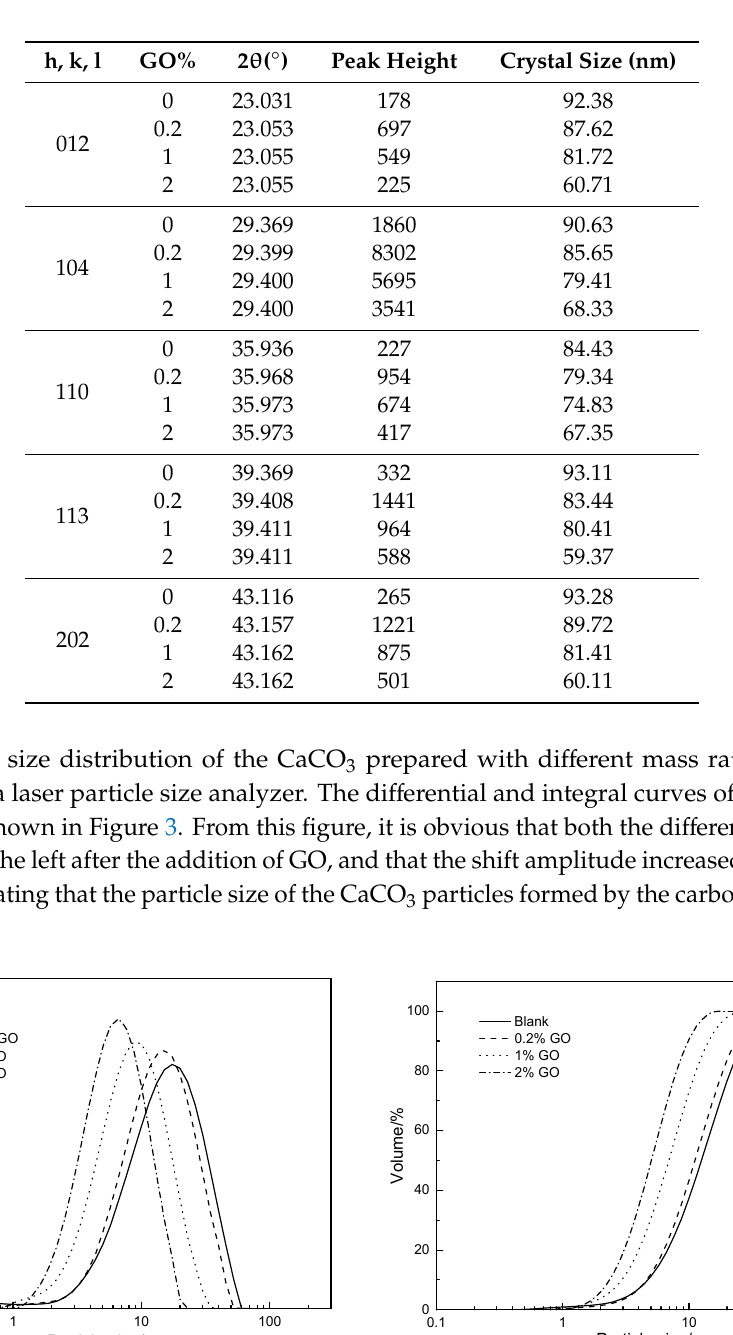
Table 1. The diffraction angle, peak height and crystal size of the calcite prepared with different content of GO. Table 1. The di ff raction angle, peak height and crystal size of the calcite prepared with di ff erent content of GO.